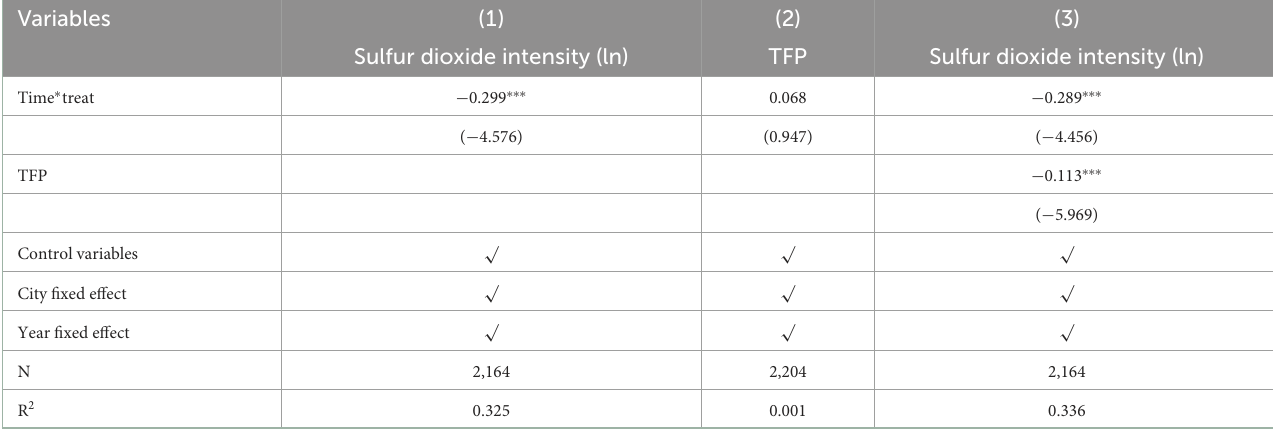
TABLE 9 Impact mechanism estimates.